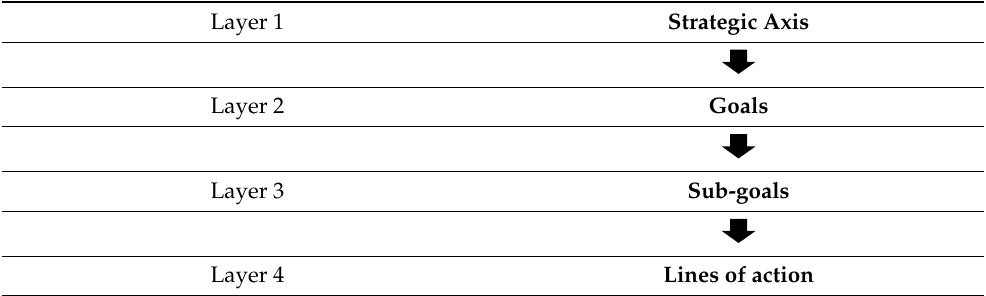
Table 1. Methodological outline of the RI.P.R.O.VA.RE. Project .